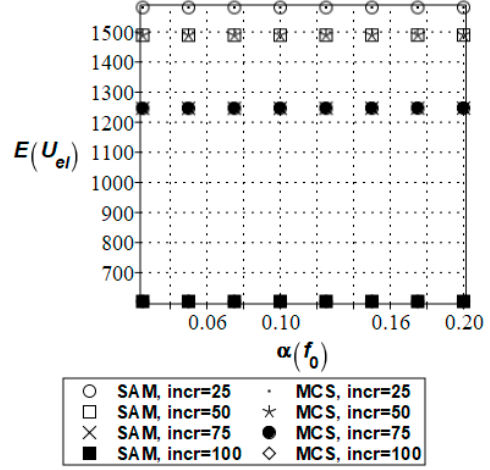
Energies 2020 , 13 , x FOR PEER REVIEW Figure 5. Expected values of elastic energy fluctuations. Figure 5. Expected values of elastic energy fluctuations.